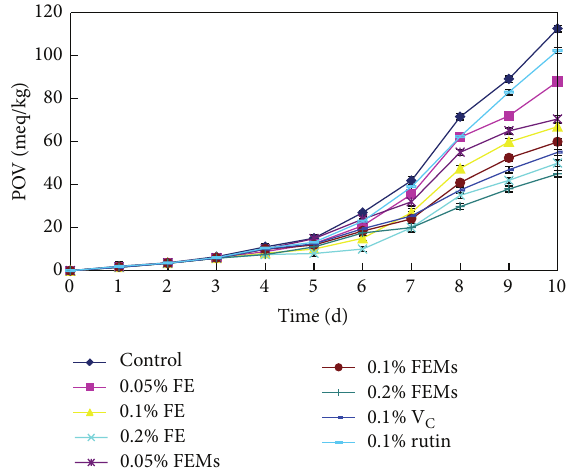
Figure 4: Inhibition effects of FEMs, FE, V C , and rutin on the lard peroxidation. Results were shown as means ± SD ( 𝑛 = 3